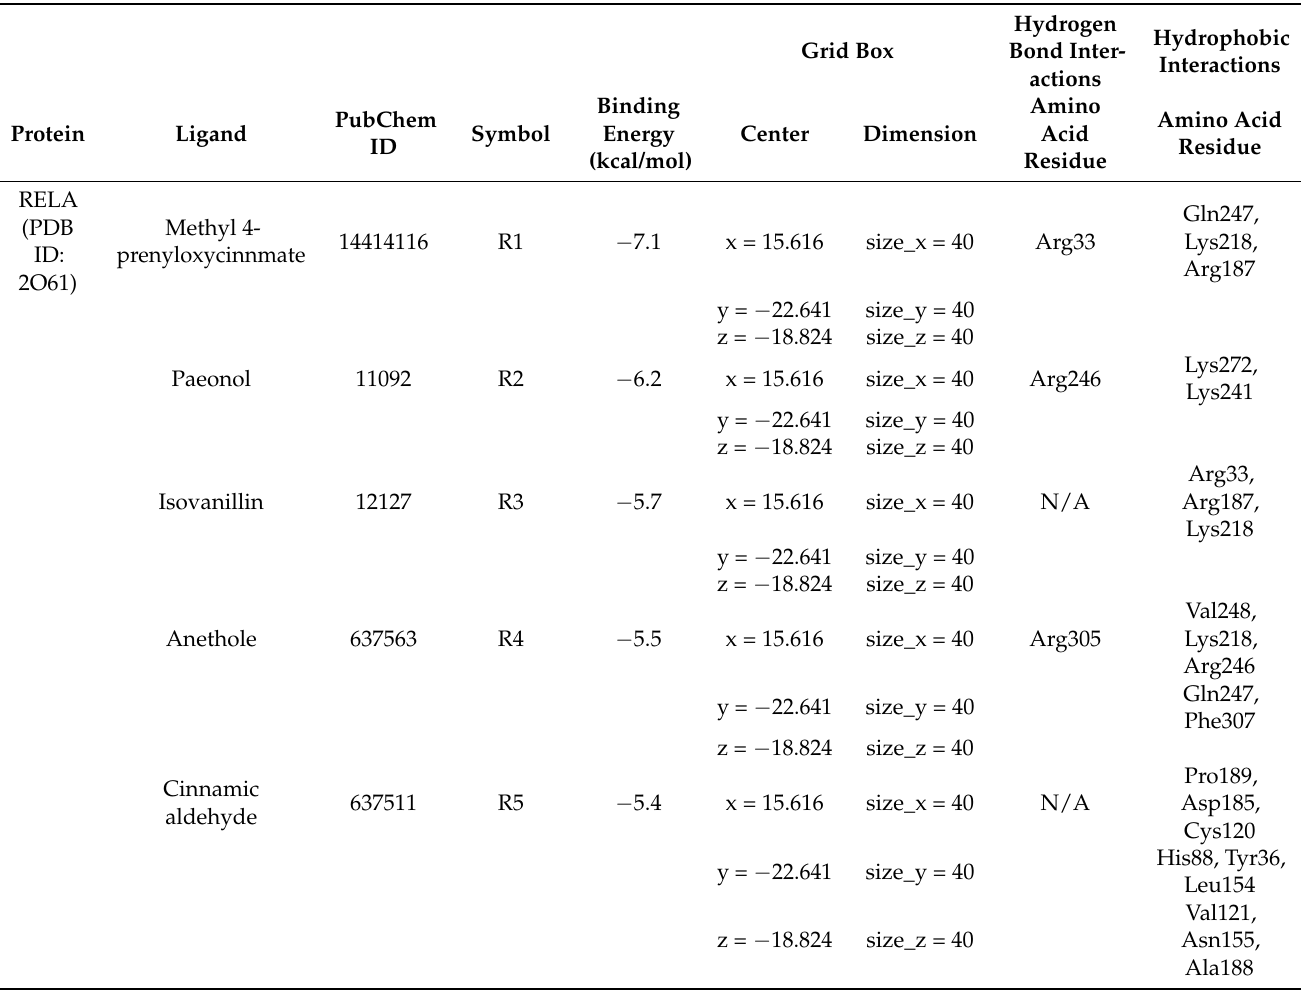
Table 5. Binding energy of potential active compounds on RELA (PDB ID: 2O61).